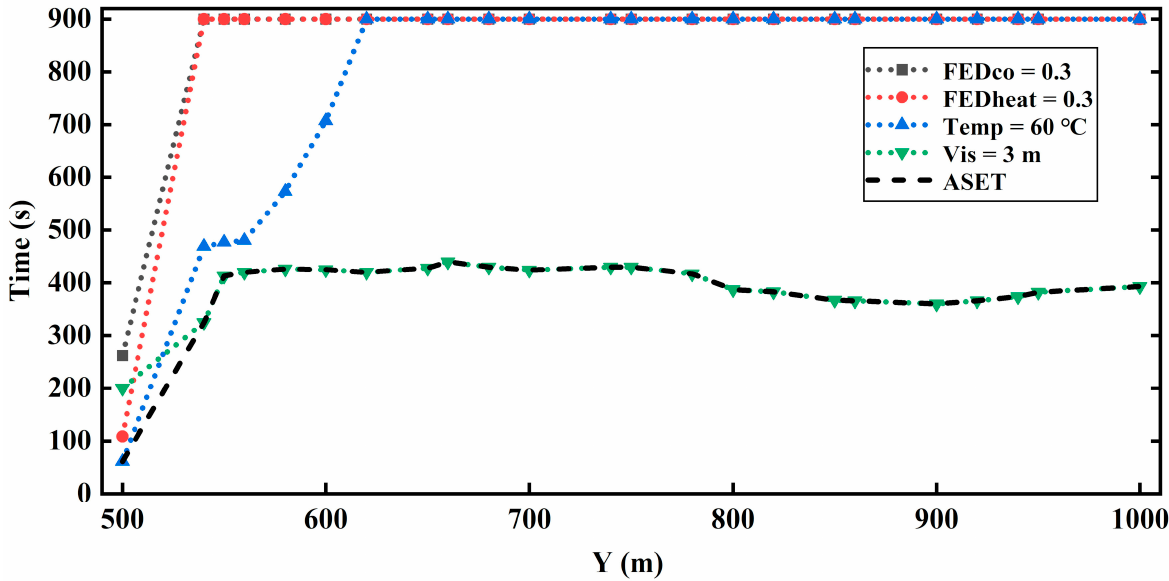
Figure 8. The downstream ASET distribution and the time when FED CO , FED heat , temperature, and visibility indexes reach the threshold at the velocity of 2.0 m/s.